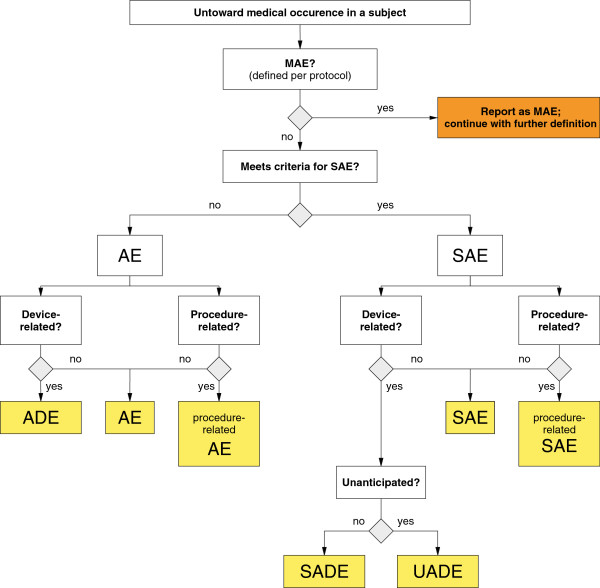
Adverse events categorization flowchart.